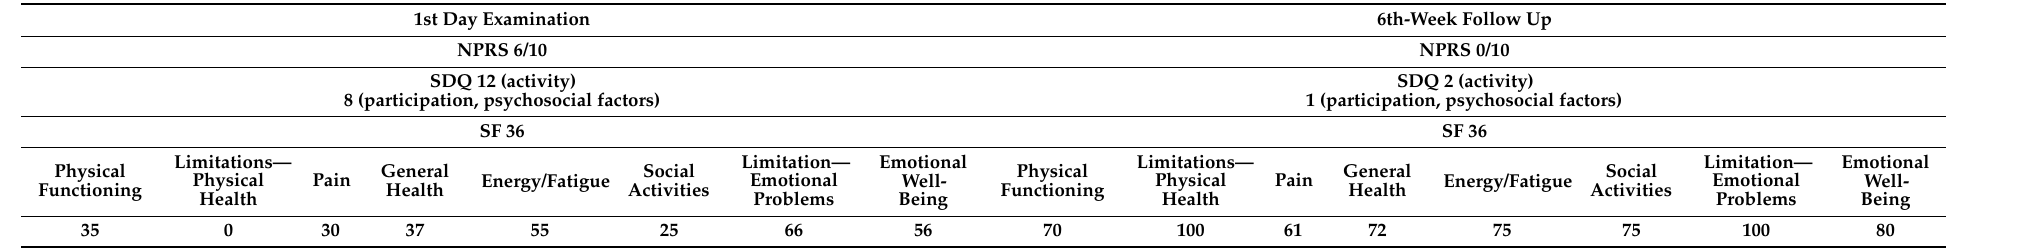
Table 2. Outcomes